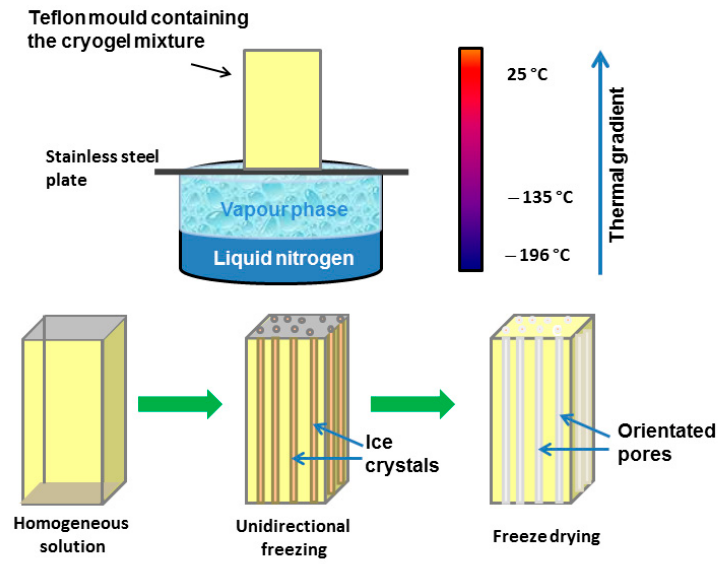
Figure 9. Process scheme for the fabrication of biopolymer scaffolds containing an oriented pore system by unidirectional freezing (scheme modified according to [37] with permission of Elsevier).